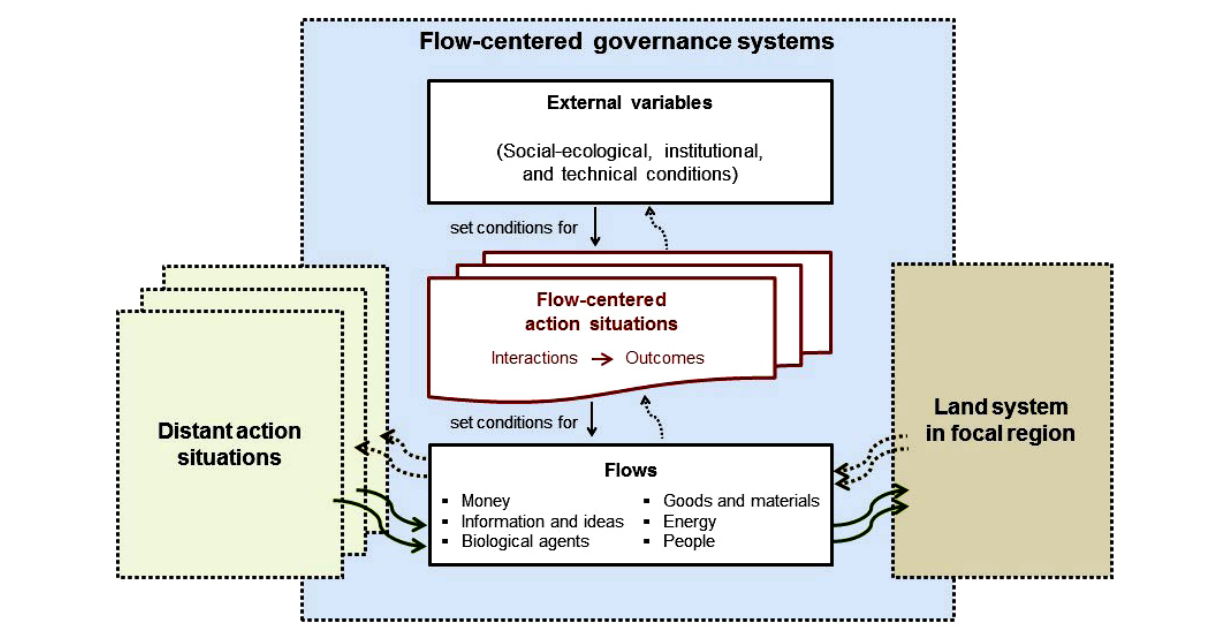
Fig. 2 . Zooming into flow-centered governance systems. Source: Authors, based on Sikor et al. (2013) and Moser and Hart (2015).